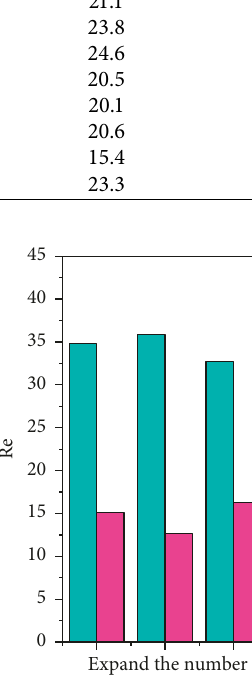
Figure 4: Comparison between the contribution rate of each source of extended data and the analytical contribution rate of PMF of measured data under different numbers of extended simulated receptor component